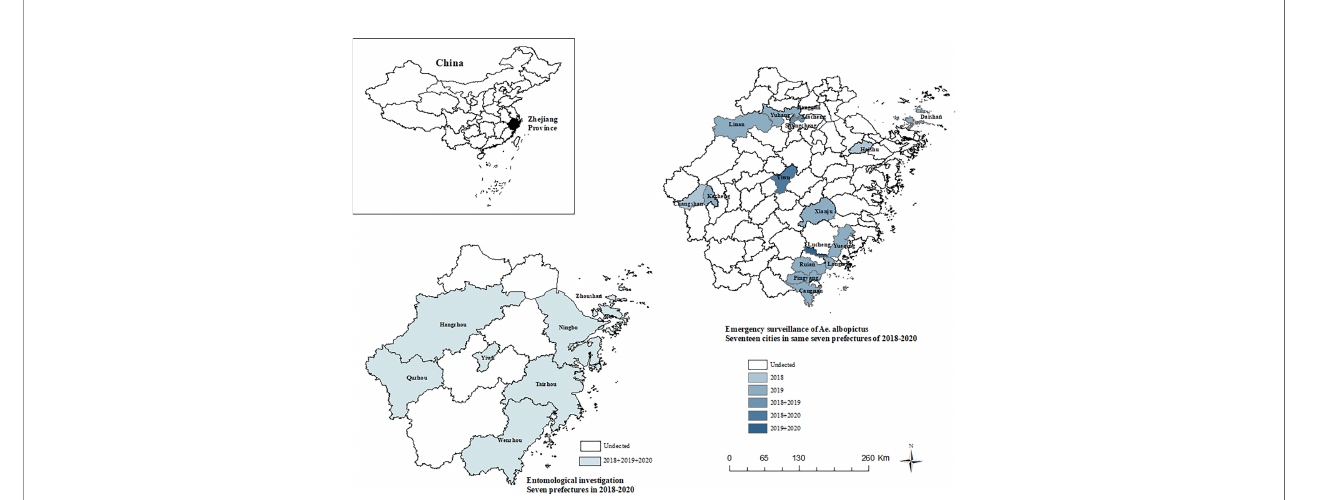
FIGURE 1 | Study area for entomological investigation and emergency surveillance of Ae. albopictus